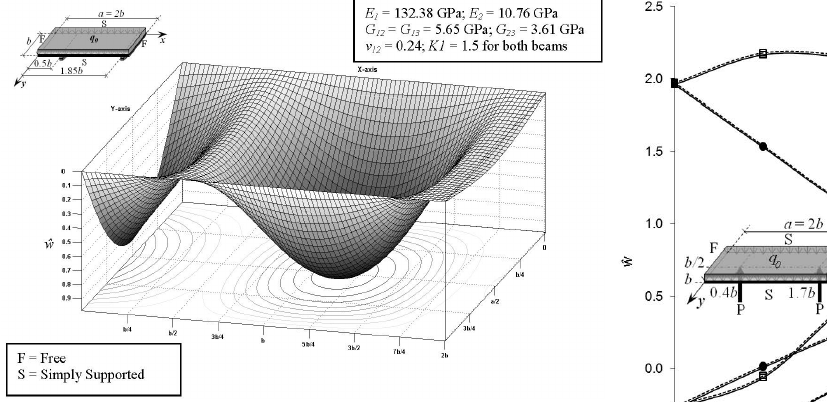
Figure 4: Contour of the dimensionless deflection, ^ w = (︁ 100 E )︁ 2 h 3 w , for a uniformly loaded antisymmetric angle-ply 10- b 4 q layer (-45/45) 5 rectangular laminated plate (Note: the isotropic beams are concentric and only half of the beams on bottom side of the plate are shown for clarity).